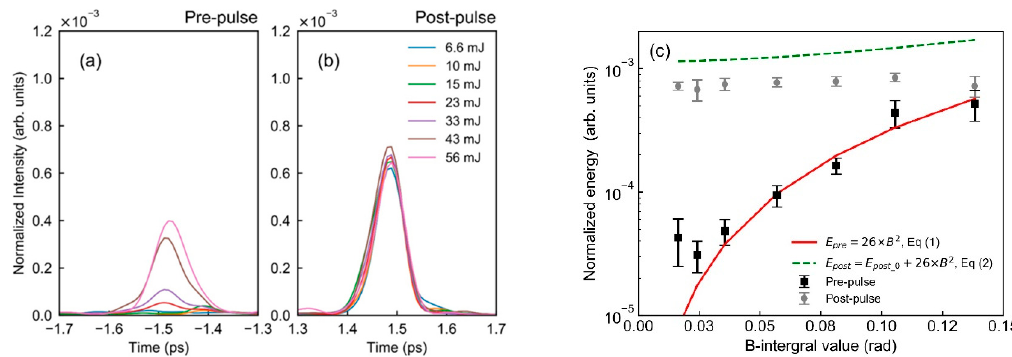
Figure 4. ( a , b ) Temporal contrast for the pre ‐ and post ‐ pulses and ( c ) normalized energy of pre ‐ and post ‐ pulses with the addition of a glass sheet at a laser energy of 23 mJ. The values in (a) and (b) indicate the number of glass plates. The experimental conditions are listed as No. 3 in Table 1. The solid line indicates the results of the approximate curves with Equation (1). The dashed line indicates the post ‐ pulse energy of Equation (2).